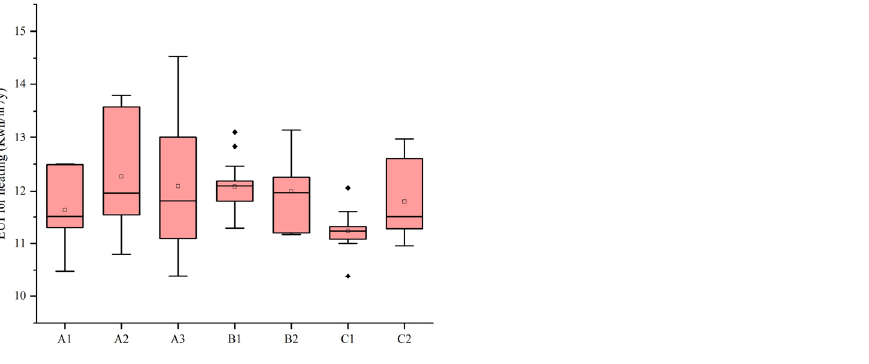
Figure 18. Distribution characteristics of EUI for heating in different typologies of office blocks.